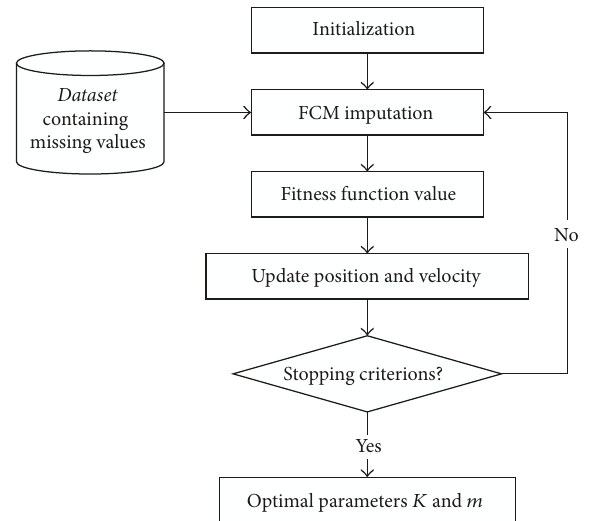
Figure 4: The flowchart of PSO-FCM-based imputation